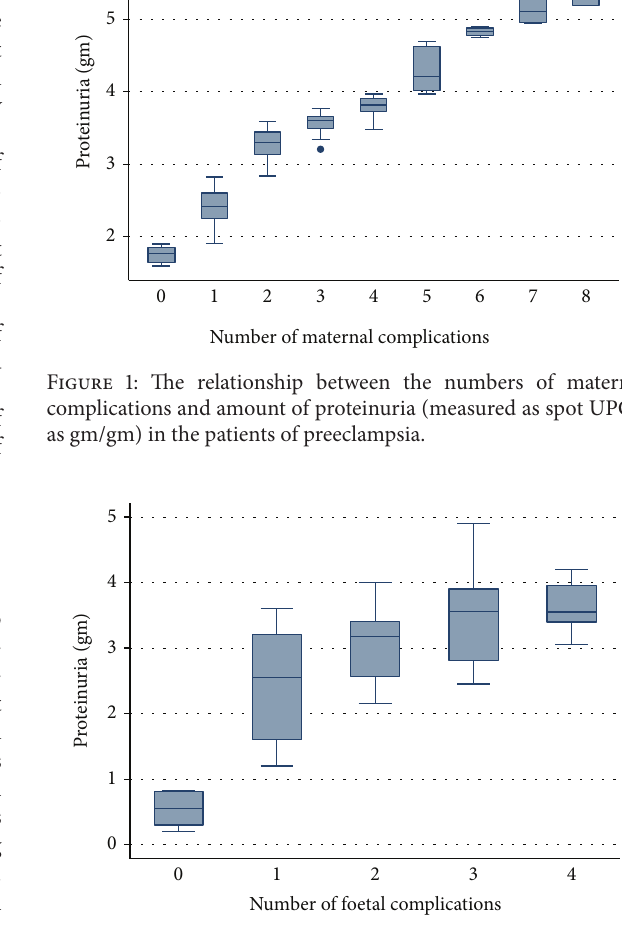
Figure 2: The relationship between the numbers of fetal compli- cations and amount of proteinuria (measured as spot UPCR as gm/gm) in the patients of